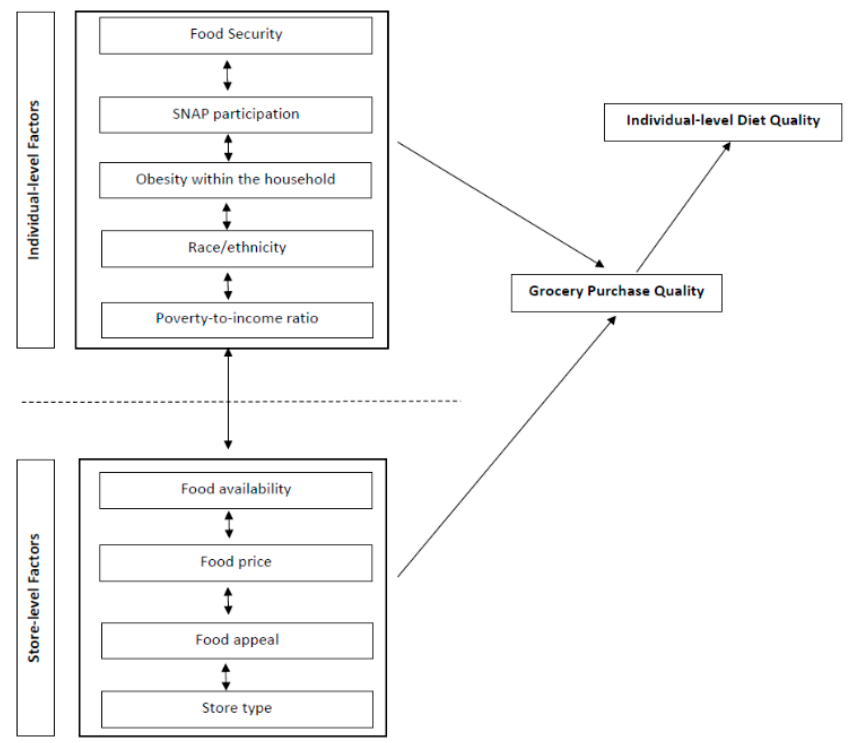
Figure 1. Conceptual framework depicts the proposed relationship between socioeconomic and demographic factors at the individual- and environmental-level that shape the dietary quality of a household’s grocery purchases and subsequent immediate home food environment and individual-level diet quality.